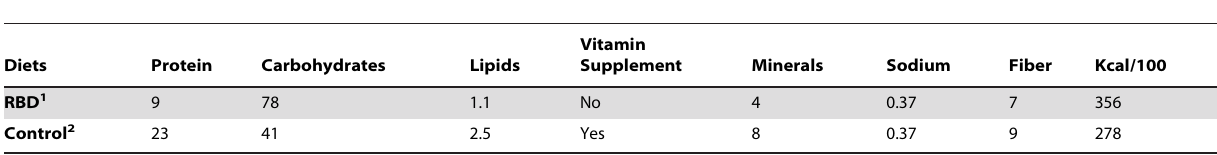
Table 1. Composition (g/g %) of the Regional Basic Diet (RBD) and the control diet.